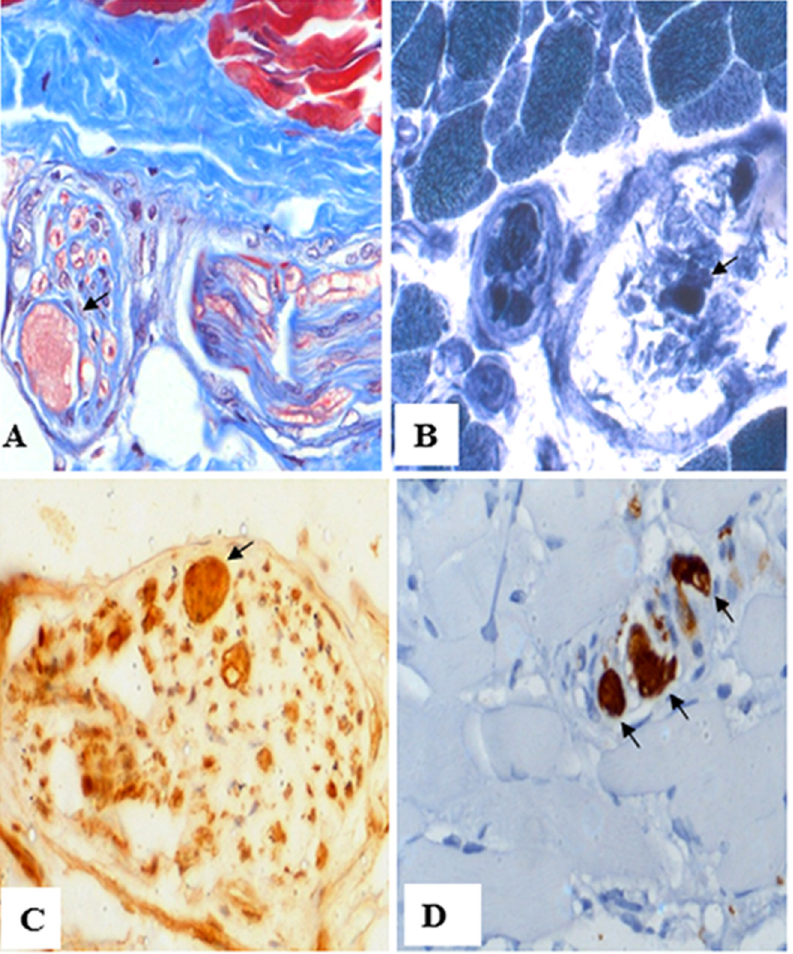
Fig 2. Muscle nerve pathology of affected individual II-1 from family 7. (A) Muscle biopsy reveals marked axonal distension of intramuscular nerve twig (arrow), using Masson's trichrome staining. (B) The intraaxonal contents in the distended axon contain NADH-TR (arrow). (C) Phosphorylated neurofilament staining (arrow). (D) Ubiquitin staining (arrow). Magnifications: (A) 200X; (B) 200X; (C) 400X; and, (D)